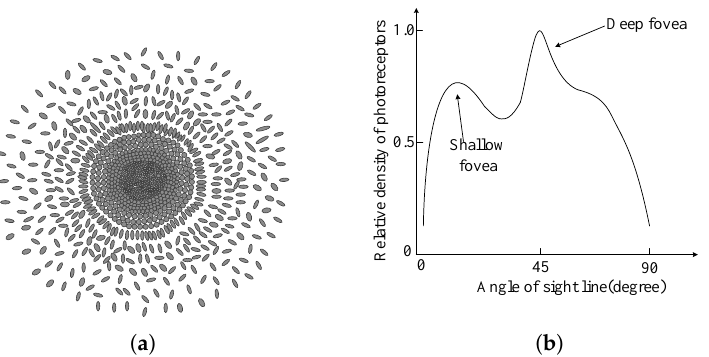
Figure 2. Distribution of cone cells in the deep fovea. ( a ) The distribution of foveal cone cells. ( b ) The relative receptor density.